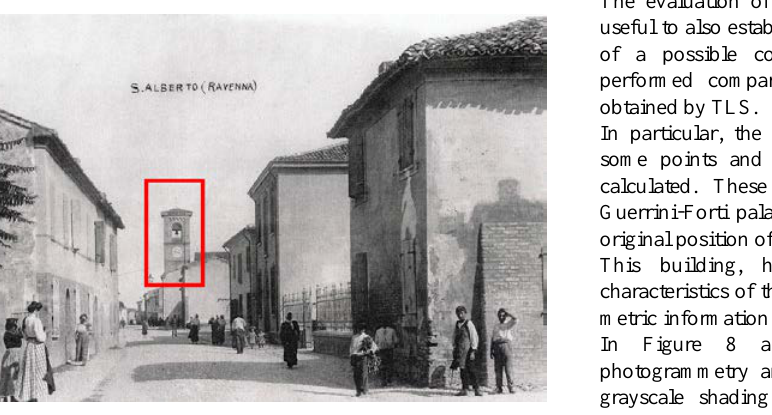
Figure 7. The historical image used to texture the North-West side of the tower (picture from private collection).